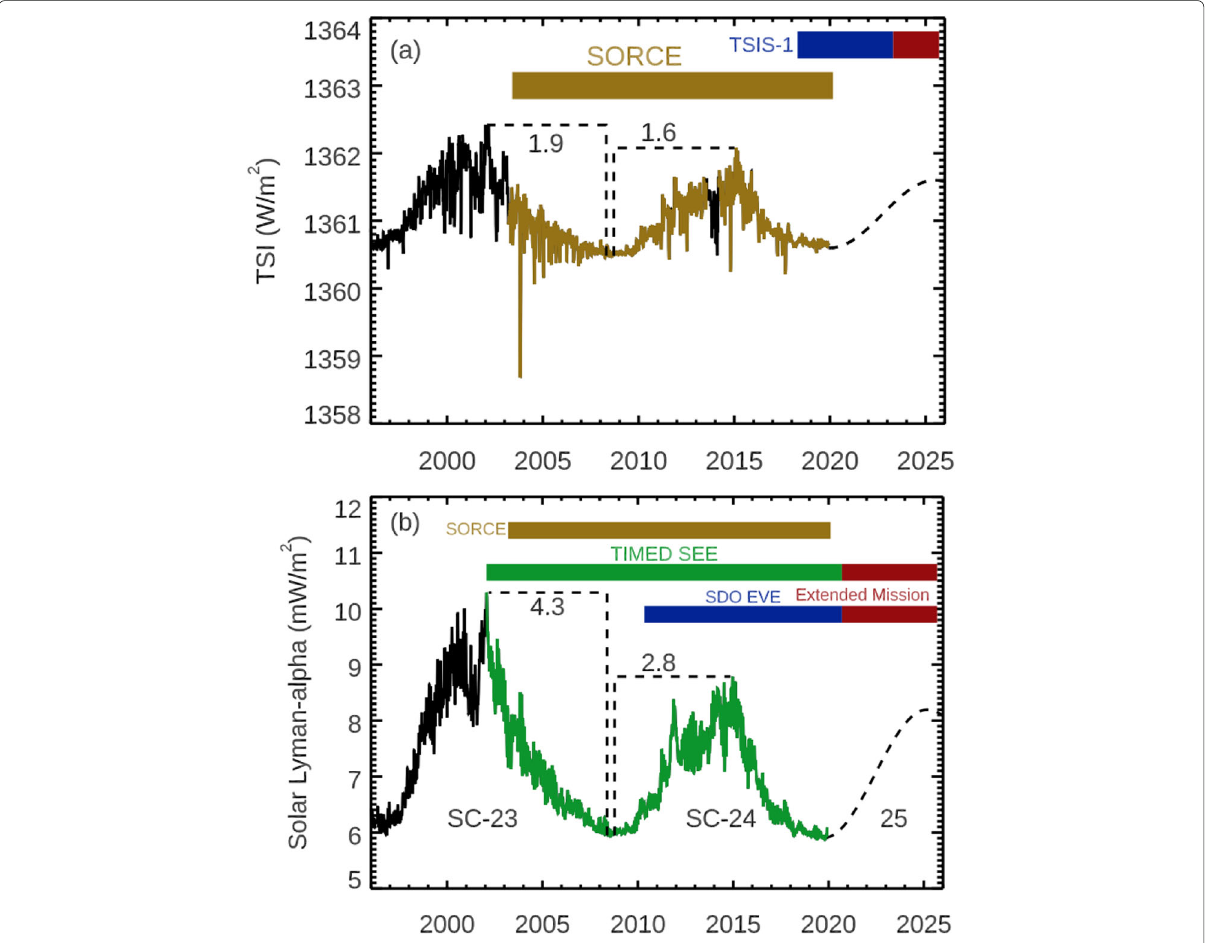
Fig. 6 Solar variability over solar cycles 23 and 24. Examples of solar variability over solar cycles (SC) 23 and 24 for a the total solar irradiance (TSI) and b the bright ultraviolet H I 121.6 nm Lyman- α emission. The SORCE TSI observations shown here are being extended with TSIS-1 observations. Important solar UV irradiance records over solar cycle (SC) 23 and 24 have been established with TIMED SEE observations, and the TIMED SEE and SDO EVE observations will be extended into the next solar minimum and cycle 25. These extensions are particularly important for overlapping with the new GOLD and ICON missions to observe the ionosphere-thermosphere during cycle